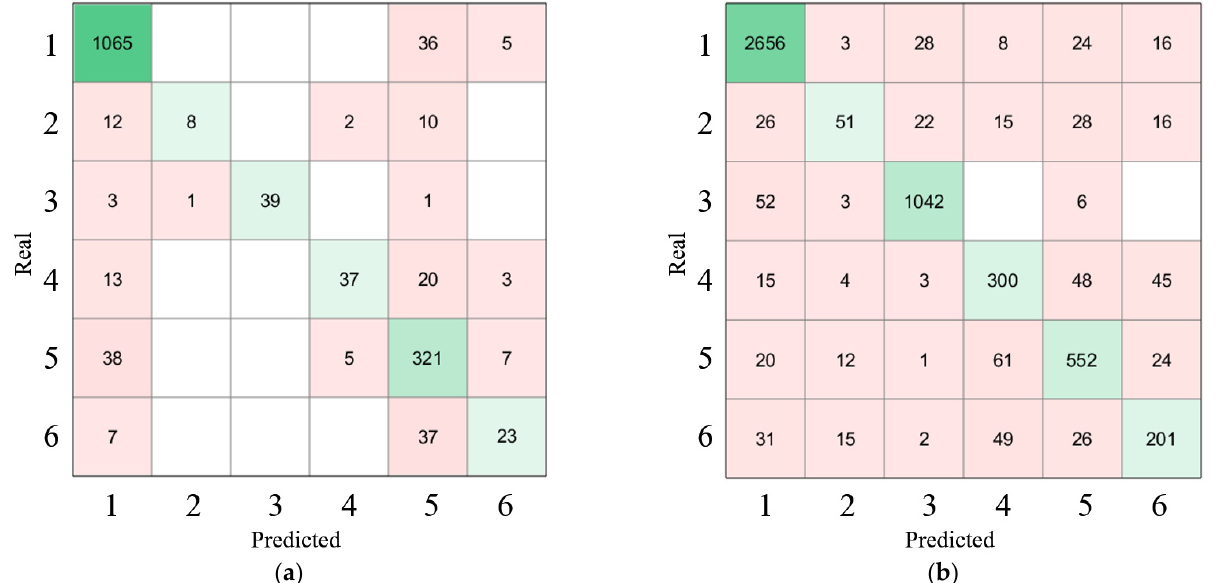
Figure 17. Confusion matrix of prediction results of arrival flight operation strategies. ( a ) ZGGG; ( b ) ZHHH.